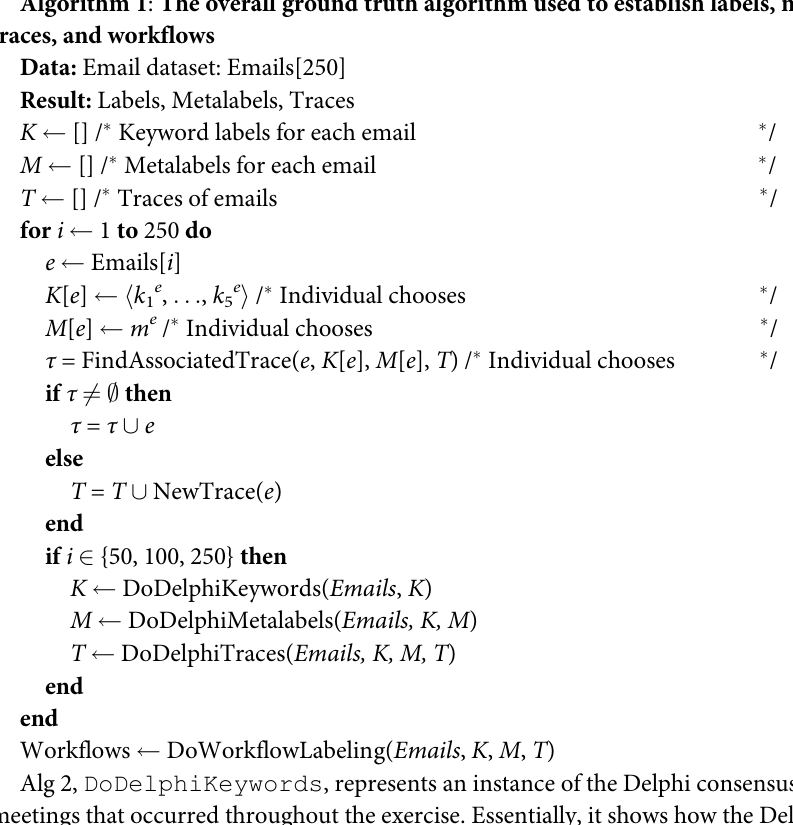
Algorithm 1 : The overall ground truth algorithm used to establish labels, metalabels, traces, and